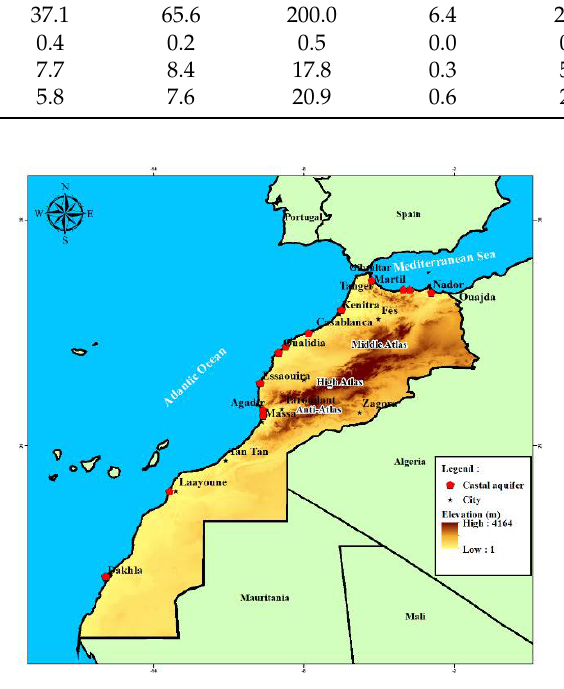
Figure 1. Location of Moroccan coastal aquifers. Table 2. List of irrigation water indices and their equations used in this study.